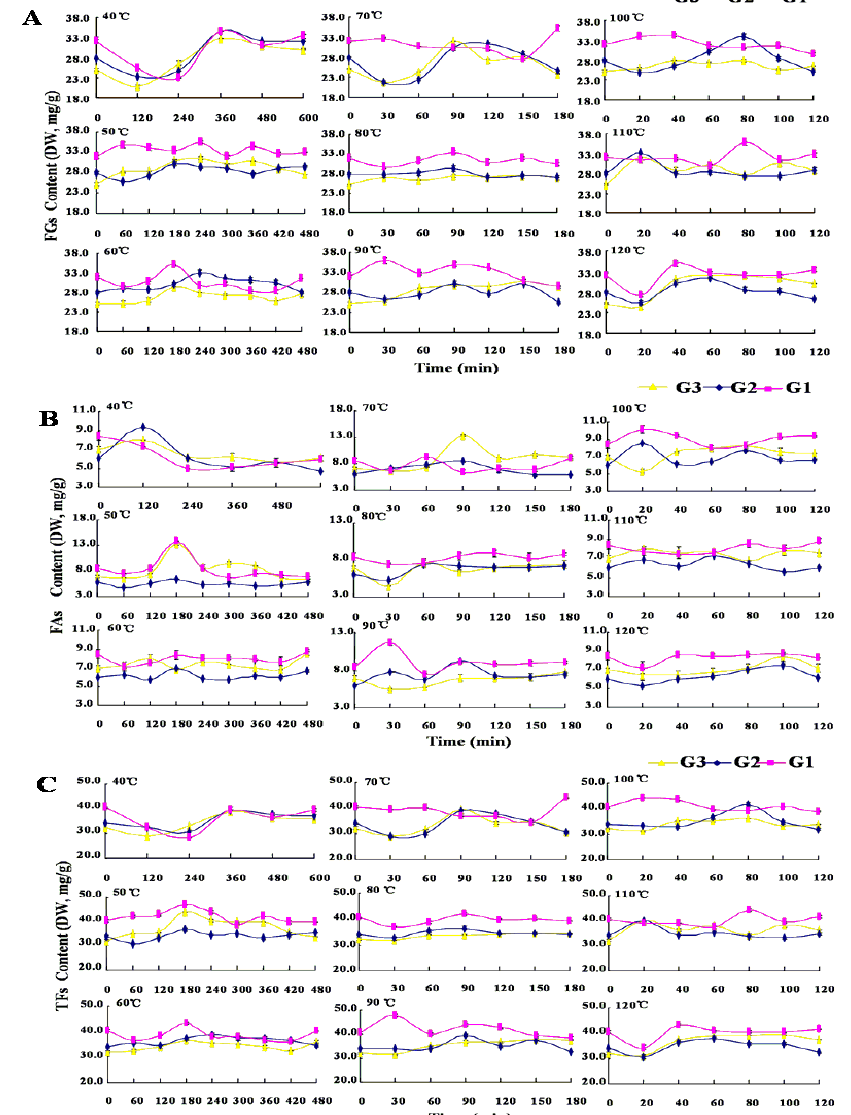
Figure 3. The contents of FGs ( A ), FAs ( B ) and TFs ( C ) during the drying process at different temperatures. G1 , grade I rhizome; G2 , grade II rhizome; G3 , grade III